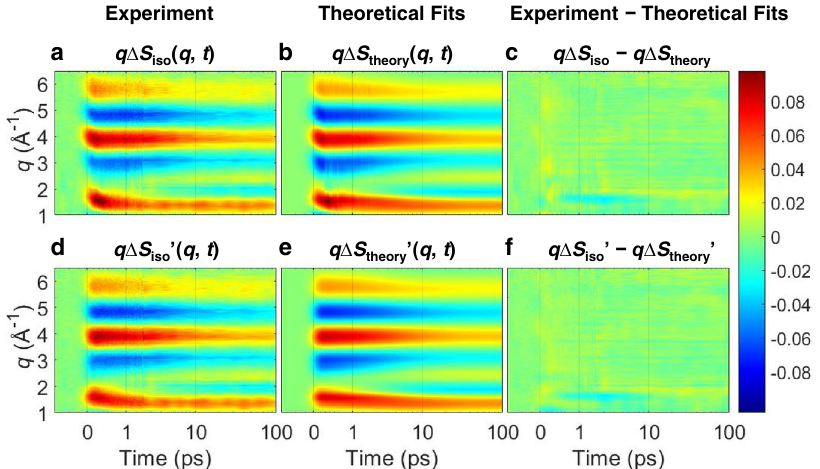
Fig. 2 Experimentally measured fs-TRXL signals with theoretical fi t results. a Experimental q Δ S iso ( q , t ). b Corresponding theoretical fi t results, q Δ S q , t ), obtained from the global fi t combined with structural analysis. c Residuals obtained by subtracting theoretical fi ts from the experimental theory ( data. d The extracted signals of exponential kinetics, q Δ S iso ’ ( q , t ). e Corresponding theoretical fi t results, q Δ S theory ’ ( q , t ), obtained from the global fi t combined with structural analysis. f Residuals obtained by subtracting theoretical fi ts from the experimental data. All plots share a color scale representing the amplitude of the signal in absolute electronic units per solvent molecule. Source data for panels ( a ) and ( d ) are provided as a Source Data fi le. reacting species, as explained later. Based on these results, the full instrumental response function (IRF). As shown in Supplemen- dataset of the isotropic signals, Δ S iso ( q , t ), was analyzed to extract tary Fig. 6a and b, a sum of four exponential functions fi t those the ultrafast structural motions of the reacting species. The fi nal two RSVs satisfactorily, whereas a sum of three exponential fi tting results presented in Fig. 2b and Supplementary Fig. 7 well functions did not. The four time constants were determined to be describe the experimental features, giving almost zero residual as 508 (±13) fs, 3.11 (±0.43) ps, 8.83 (±1.11) ps, and 11.90 (±1.67) shown in Fig. 2c. More detailed procedures for the data analysis ps, and the full width at half-maximum (FWHM) of the IRF was are given in Methods and Supplementary Methods and will be determined to be 162 (±7) fs. First, we analyzed Δ S iso ’ ( q , t ) to obtain the population kinetics and the equilibrium structures of brie fl y described in the following sections as well. NATURE COMMUNICATIONS| (2021) 12:4732